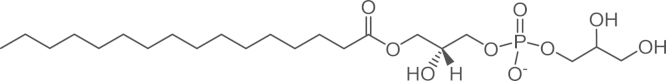
Structure of the phospholipid analog detergents 1-palmitoyl-2-hydroxy-sn-glycero-3-phospho-(1′-rac-glycerol) (LFG-16) used for the solubilization nicotinic acetylcholine receptor from Torpedo californica electric organ, using the phospholipid analog detergent 1-palmitoyl-2-hydroxy-sn-glycero-3-phospho-(1′-rac-glycerol) (LFG-16).